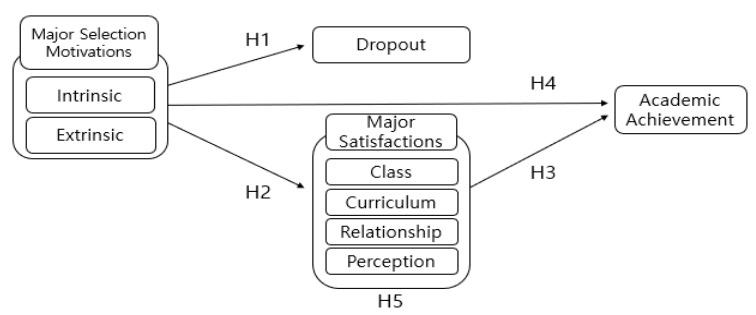
Figure 1. Research Model.